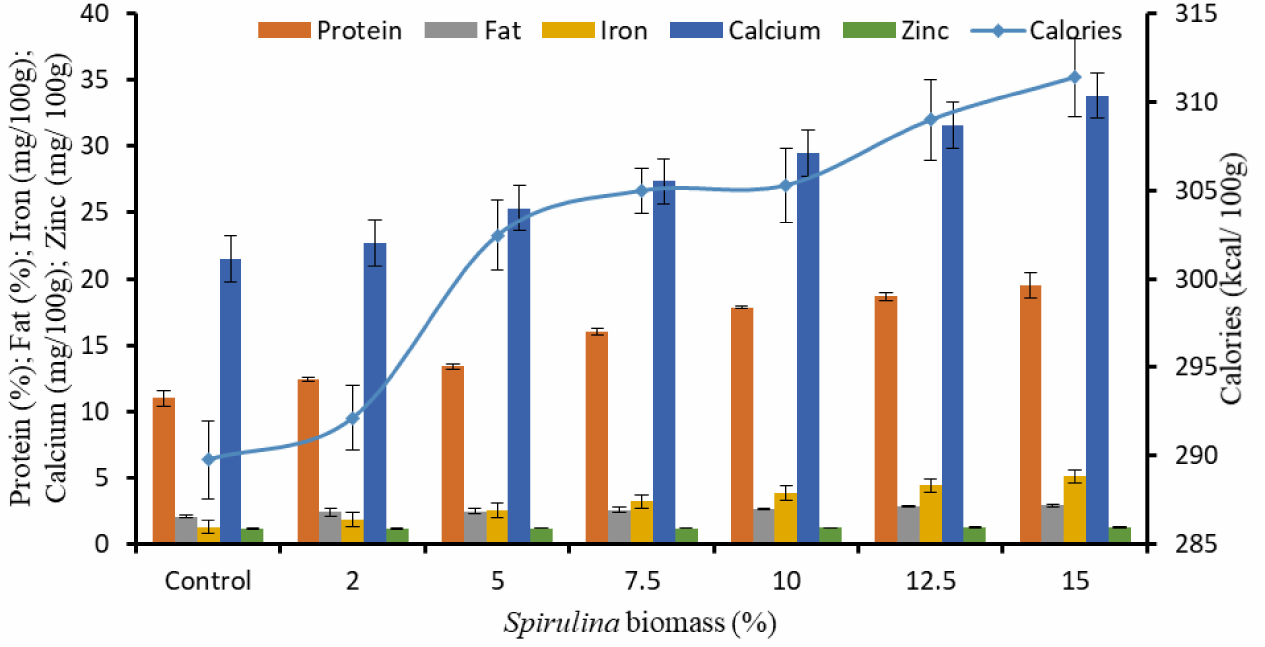
Figure 2. Proximate and mineral composition of cooked pasta enriched with different concentration of Spirulina